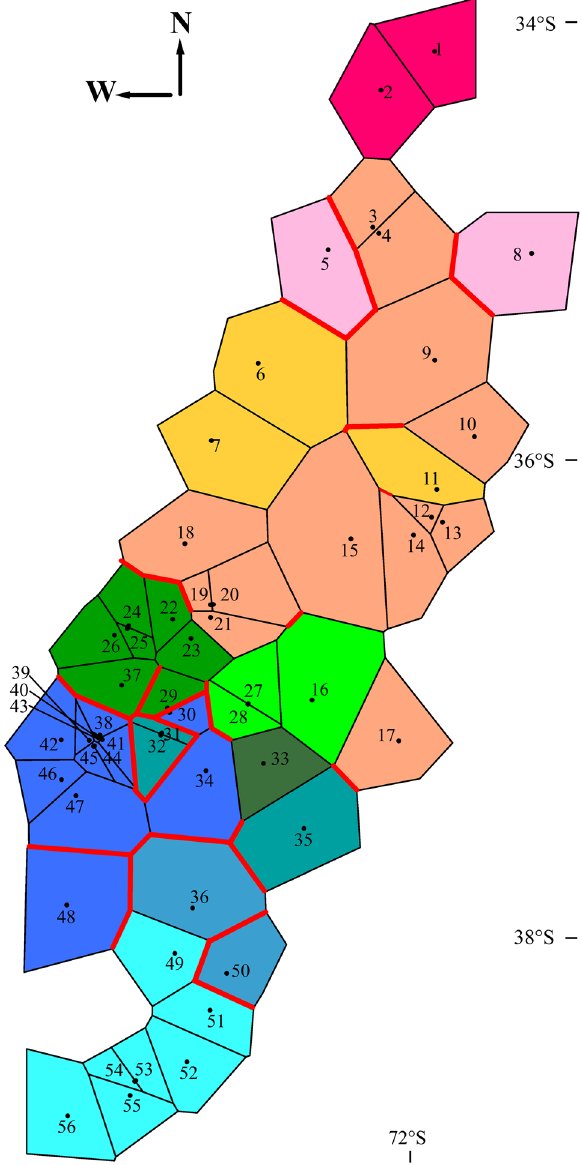
Figure 4. Genetic clusters (obtained from SAMOVA) and barriers based on the distribution of the genetic variation of the COI gene of Parastacus pugnax . Colors distinguish each cluster. Numbers correspond to each locality as indicated in Table 1. The red lines indicate the barriers determined by BARRIER 2.2.